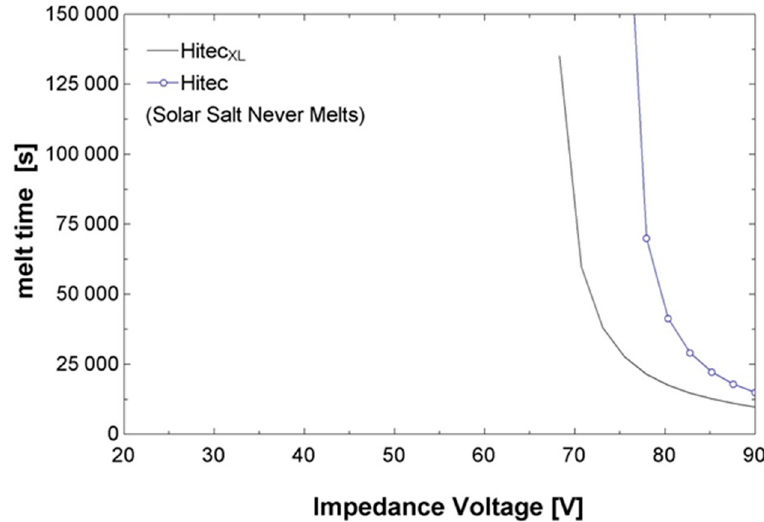
Figure 13. Melting time as a function of the total solar collector assembly impedance voltage with the following system configurations: Solar radiation = 0 W/m 2 , wind speed = 5 m/s, glazing intact, air in annulus at 1 atm, ambient temperature = 15 °C.